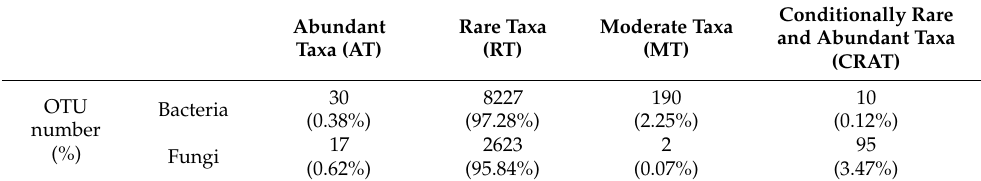
Table 1. Identification and information of abundant and rare bacteria and